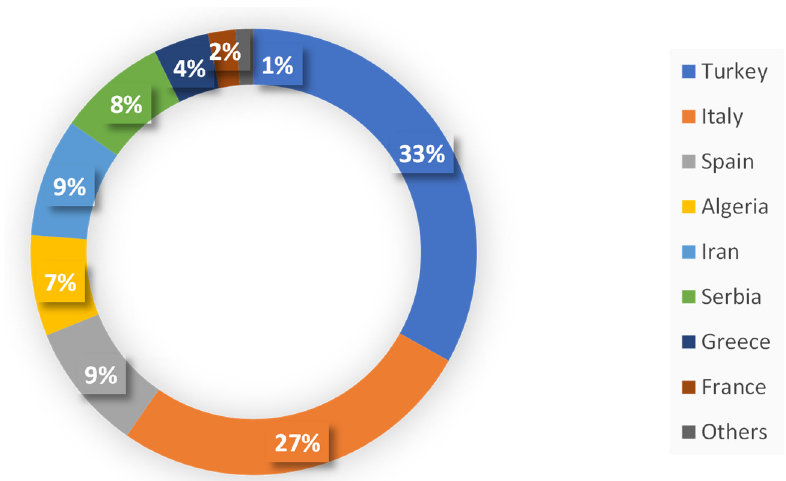
Figure 2. Distribution of authors by country of origin.